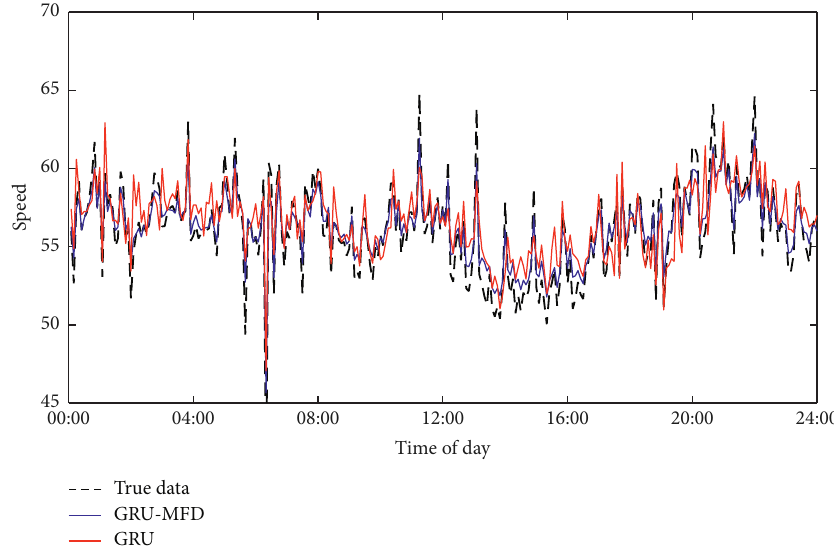
Figure 10: Prediction results on July 2, 2018, Section 2.